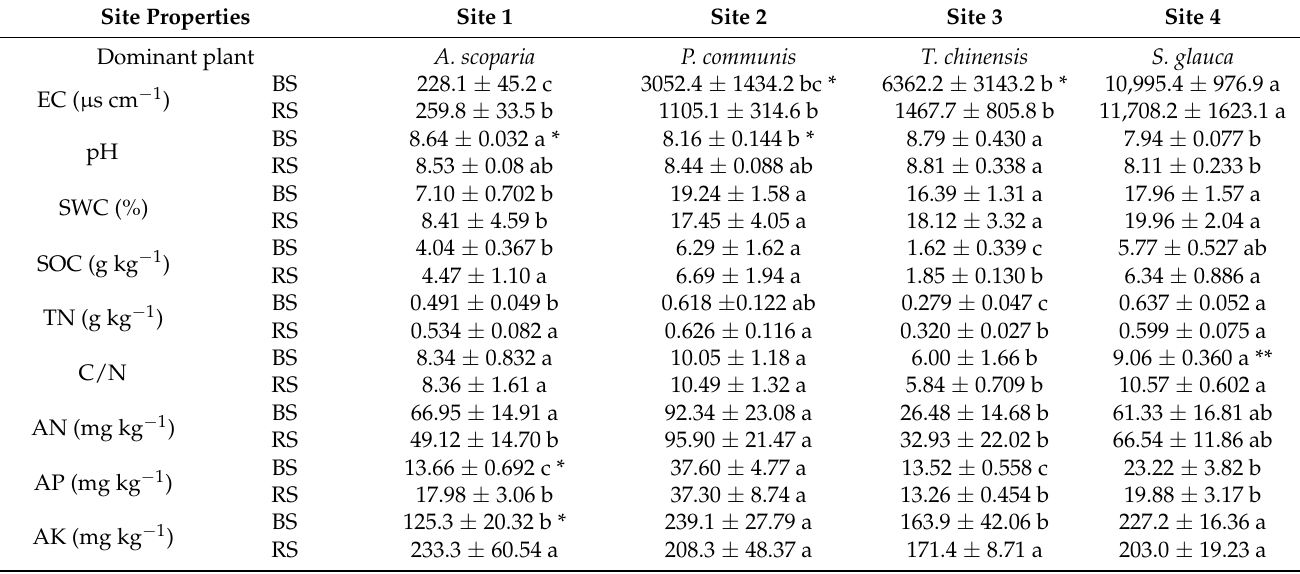
Table 1. Soil properties of the rhizosphere and bulk soil in the plots of four sampling sites. Values are given as mean ± standard deviation (SD) of the soil